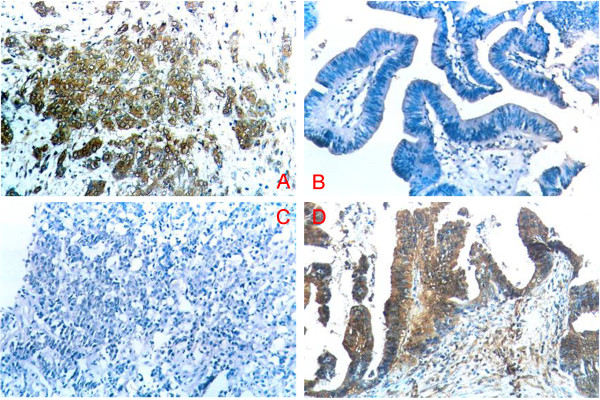
Expression of brain-derived neurotrophic factor (BDNF) and bone morphogenetic protein receptor type IA (BMPR1A)in benign and malignant gallbladder lesions. (A) Positive expression of BDNF in adenocarcinoma, and (B) negative expression of BDNF in a benign lesion. (C) Negative expression of BMPR1A in adenocarcinoma and (D) positive expression of BMPR1A in a benign lesion. The positive reaction for both BDNF and BMPR1A was mainly localized to the cytoplasm and/or cell membrane. Original magnification × 200.